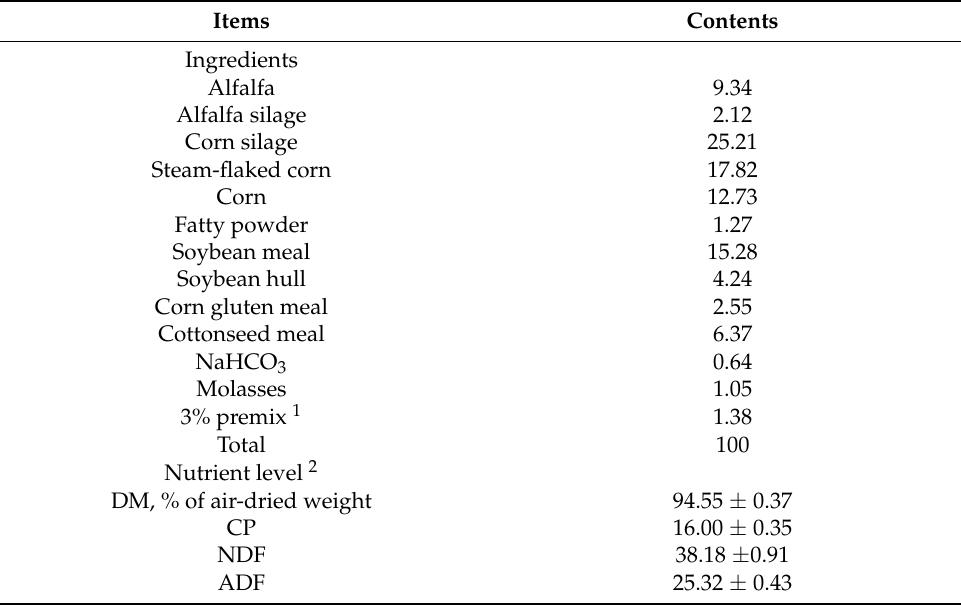
Table 1. The ingredients and nutrient composition of total mixed ration fed to cows and the substrate, % of dry matter